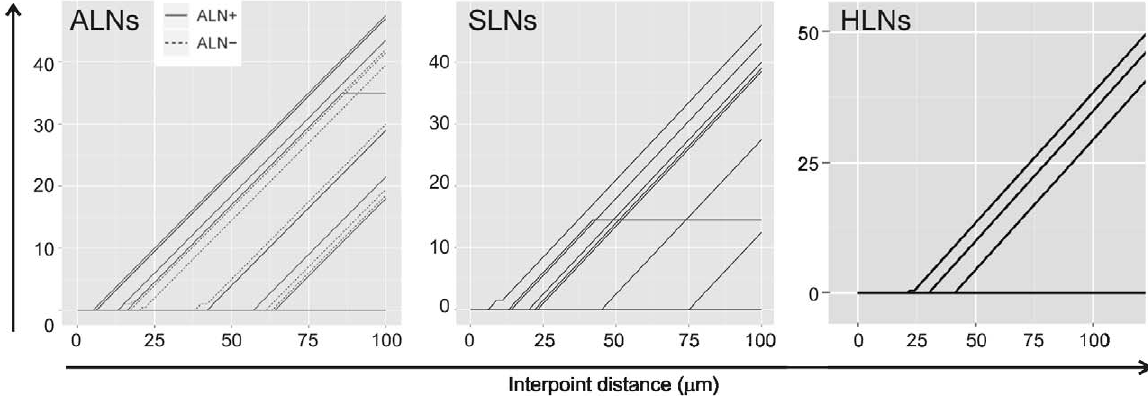
Figure 3. Plots illustrating the number of TDLNs and HLNs in which B cells were found to be more clustered than the T cells. Each line represents data from 1 lymph node. The shorter the interpoint distance at which the B cells’ L function exited above the confidence envelope, the more clustered B cells are compared to the T cells. Below the interpoint distance of 100 m m, the number of lines that represent the L function of B cells outside of the T cells’ envelope is as follows: 9 out of 10 (90%) ALNs + , 6 out of 10 ALNs 2 , 8 out of 15 (53%) SLNs + and 3 out of 7 (43%) HLNs. The counts indicated how much more clustered B cells are compared to T cells, and were determined as follows: we evaluated the L-function of the B cells for interpoint distances of 0 to 100 m m in 2 m m increments and compared it with the confidence envelope of the L-function for the T cells. For each interpoint distance increment of 2 m m for which the L-function of the B cells lay above the envelope, the value of the counts increased by one. The starting point was set at